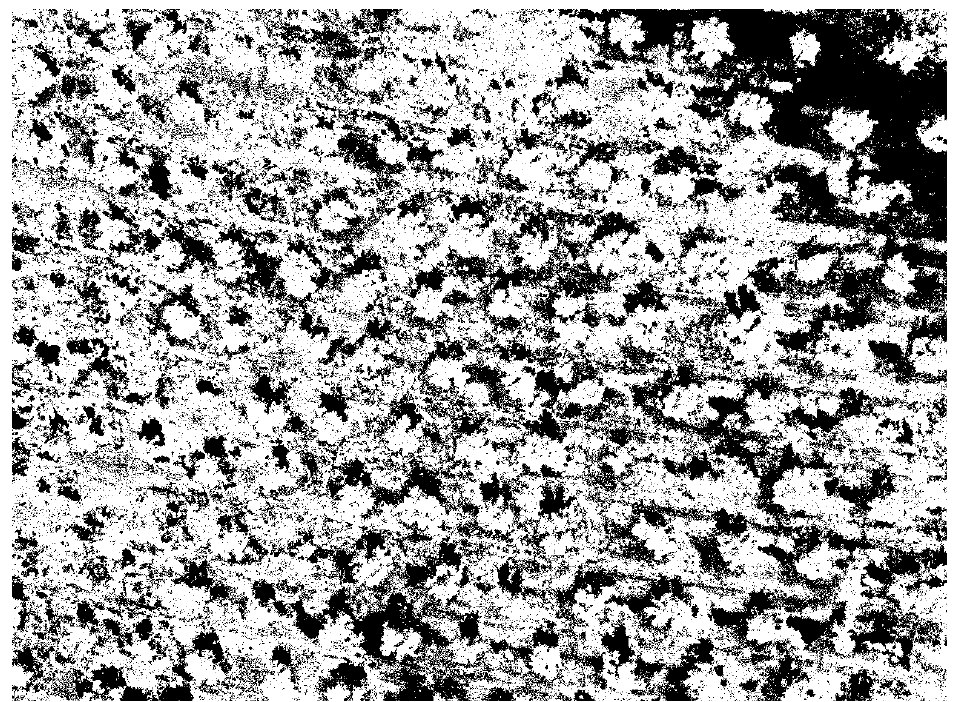
Figure 4. Vegetation mask associated with capture 0. It is a black and white image in which the white pixels were predicted as belonging to the vegetation class by a one-class classification algorithm known as local outlier factor.